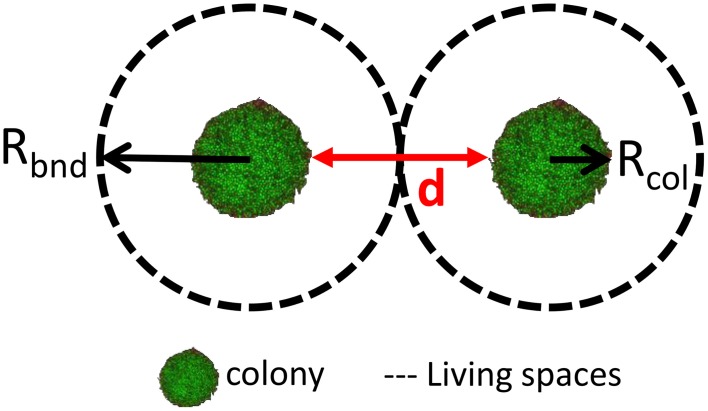
Representation of the colony and its surrounding “living space” (the area within which the colony is active) with the two respective radii Rcol and Rbnd; d is the distance between two neighboring colonies. Adapted from Malakar et al. (2002a) and Wimpenny (1992).